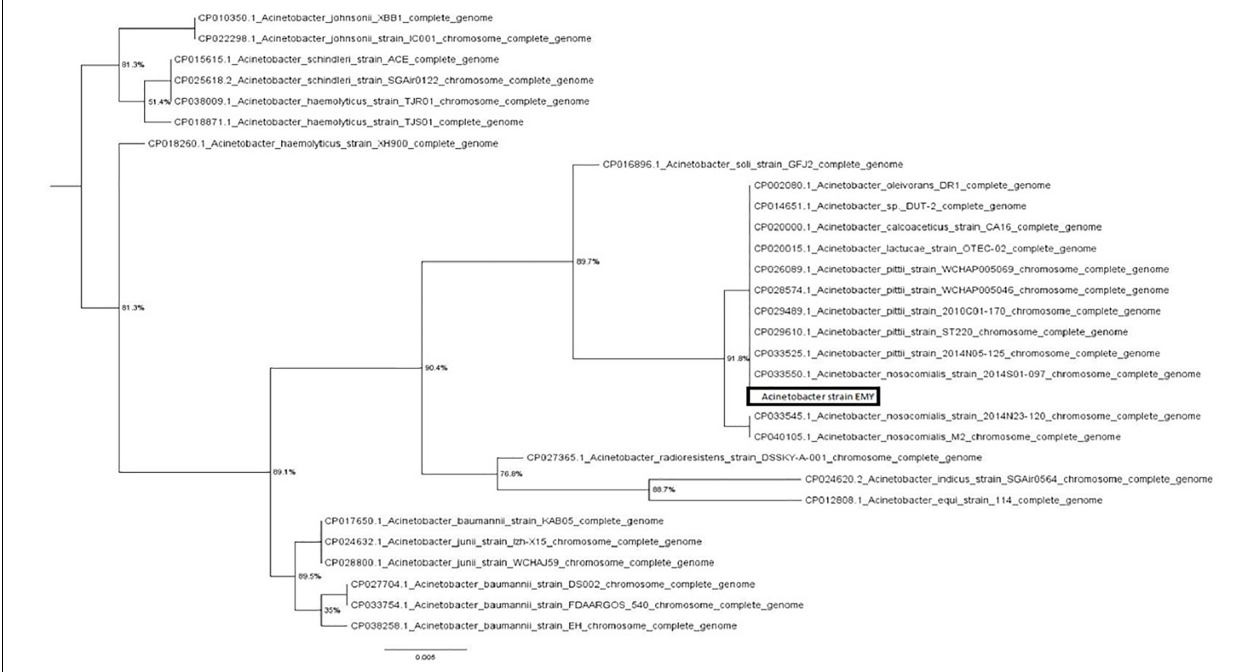
FIGURE 2 | Approximate maximum likelihood tree based on a partial 16S rRNA gene sequence of Acinetobacter strain EMY. The scale bar represents the rate of substitution per site. Numbers at nodes indicate local support values estimated by the Shimodaira-Hasegawa test based on 1,000 re-samplings.